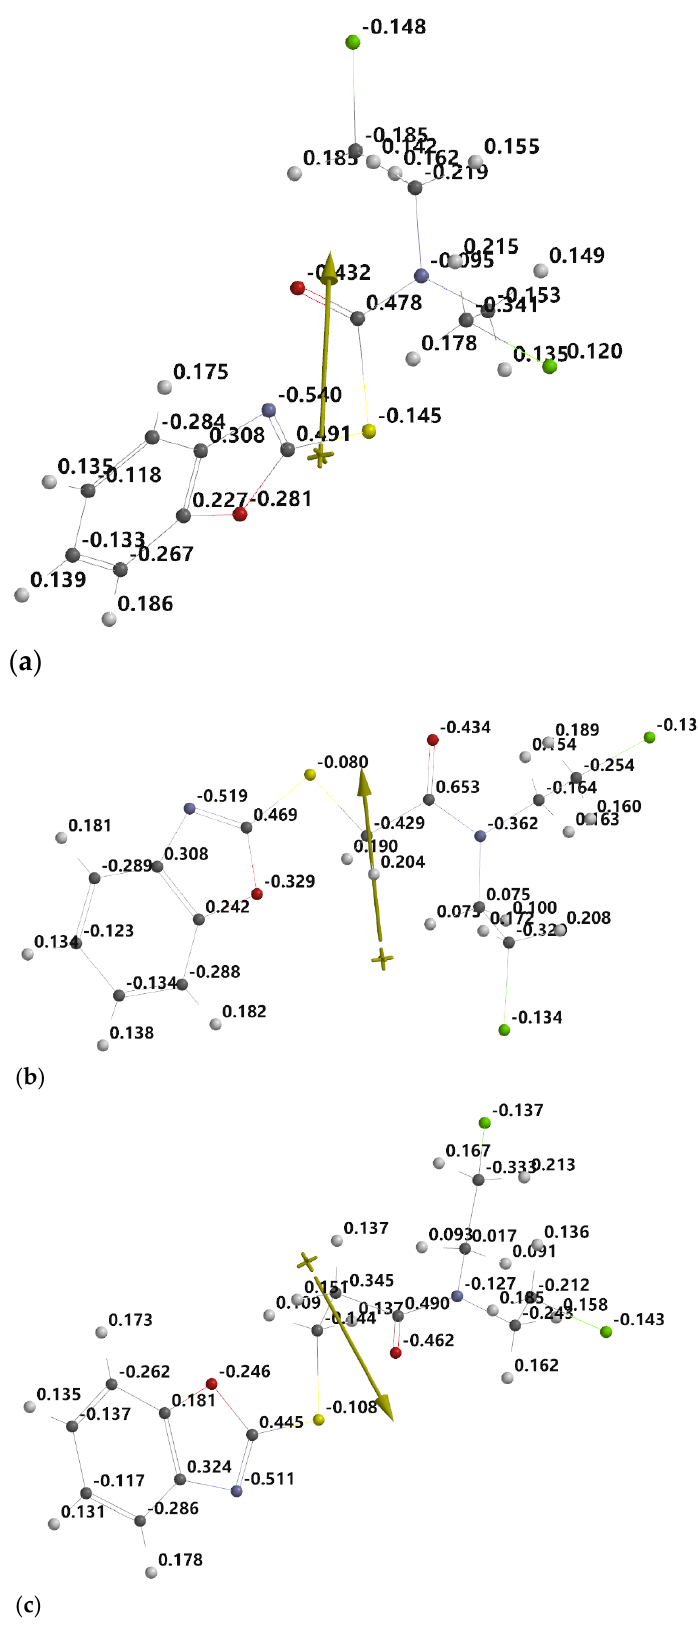
( b ) Figure 8. Local ionization map ( a ) and |LUMO| map ( b ) for molecule X. Some information can be extracted from the analysis of Figures 6–8. The local ionization potential map (Figures 6a, 7a and 8a) is an indicator of the elec- trophile addition. Colors in red correspond to small ionization potentials, while colors in blue correspond to high ionization potentials. The studied molecules are characterized by high and intermediate ionization potentials. |LUMO| map (Figures 6b, 7b and 8b) is an indicator of nucleophilic addition. Colors